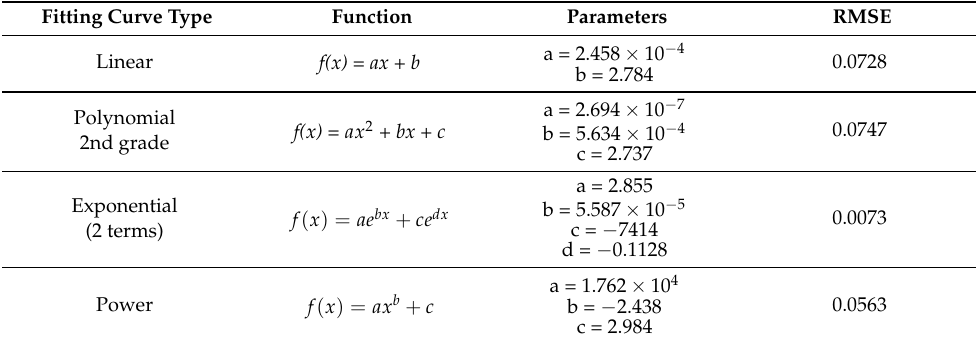
Table 6. Comparison between fitting curves for aSF results.